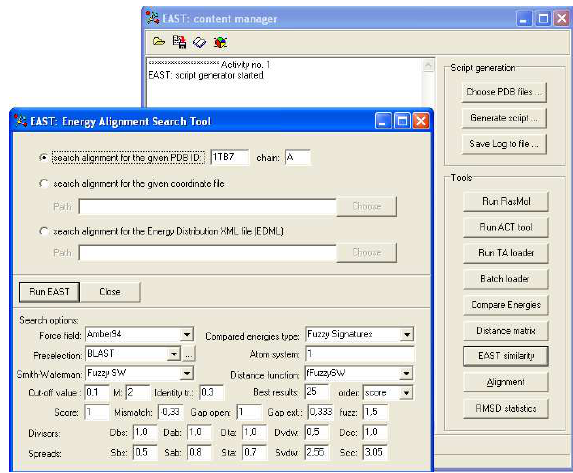
Fig. 11. EAST similarity searching execution panel.